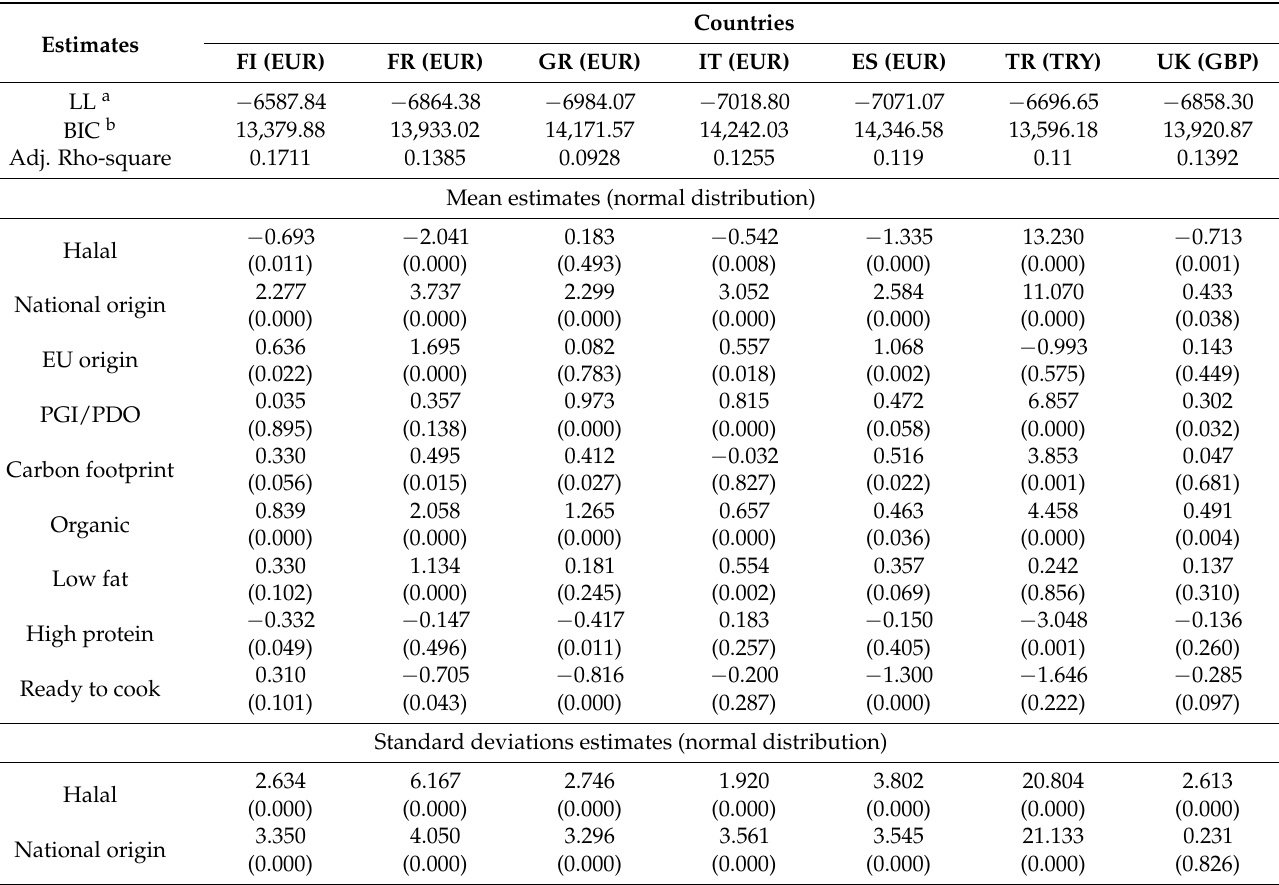
Table 5. Estimated willingness to pay (WTP) for all countries in local coin.